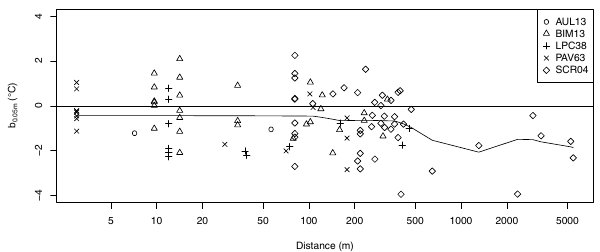
Figure 3. Measurements and LOWESS of the bias of T 0 . 50m as a function of the distance between the measurement point and the nearest valid pixel in the satellite image.